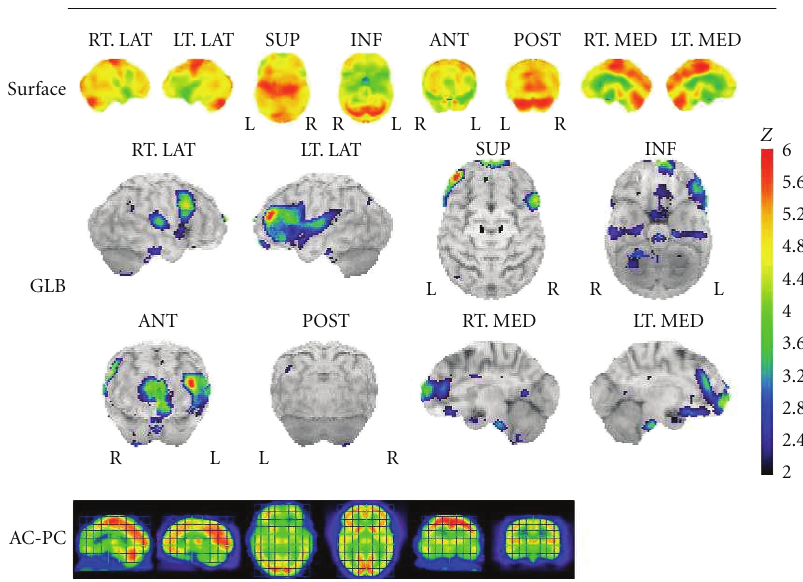
Figure 2: Three-dimensional stereotactic surface projections on brain single photon emission computed tomography show decreased blood flow in the frontal lobes, predominantly on the left